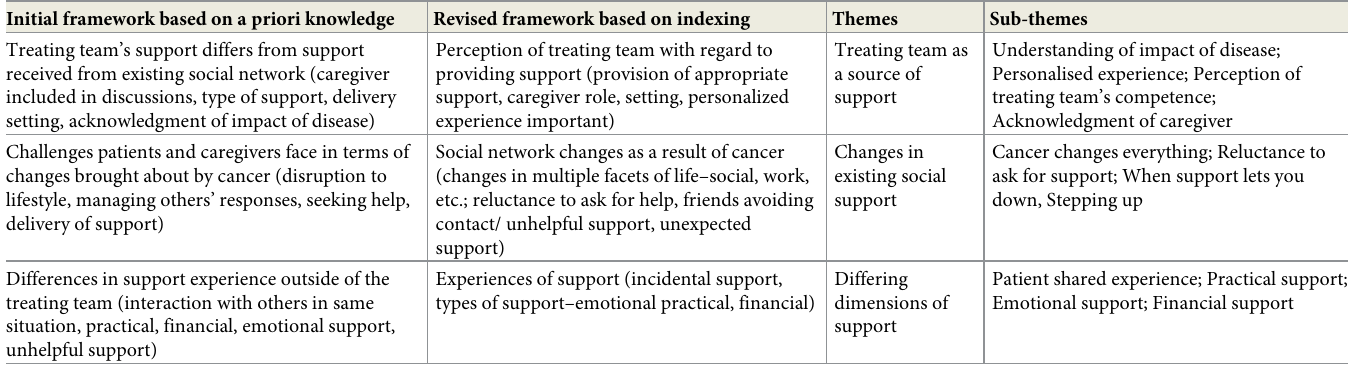
Table 1. Application of framework analysis for colorectal patient and caregiver experiences of support within the cancer treatment setting. Initial framework based on a priori